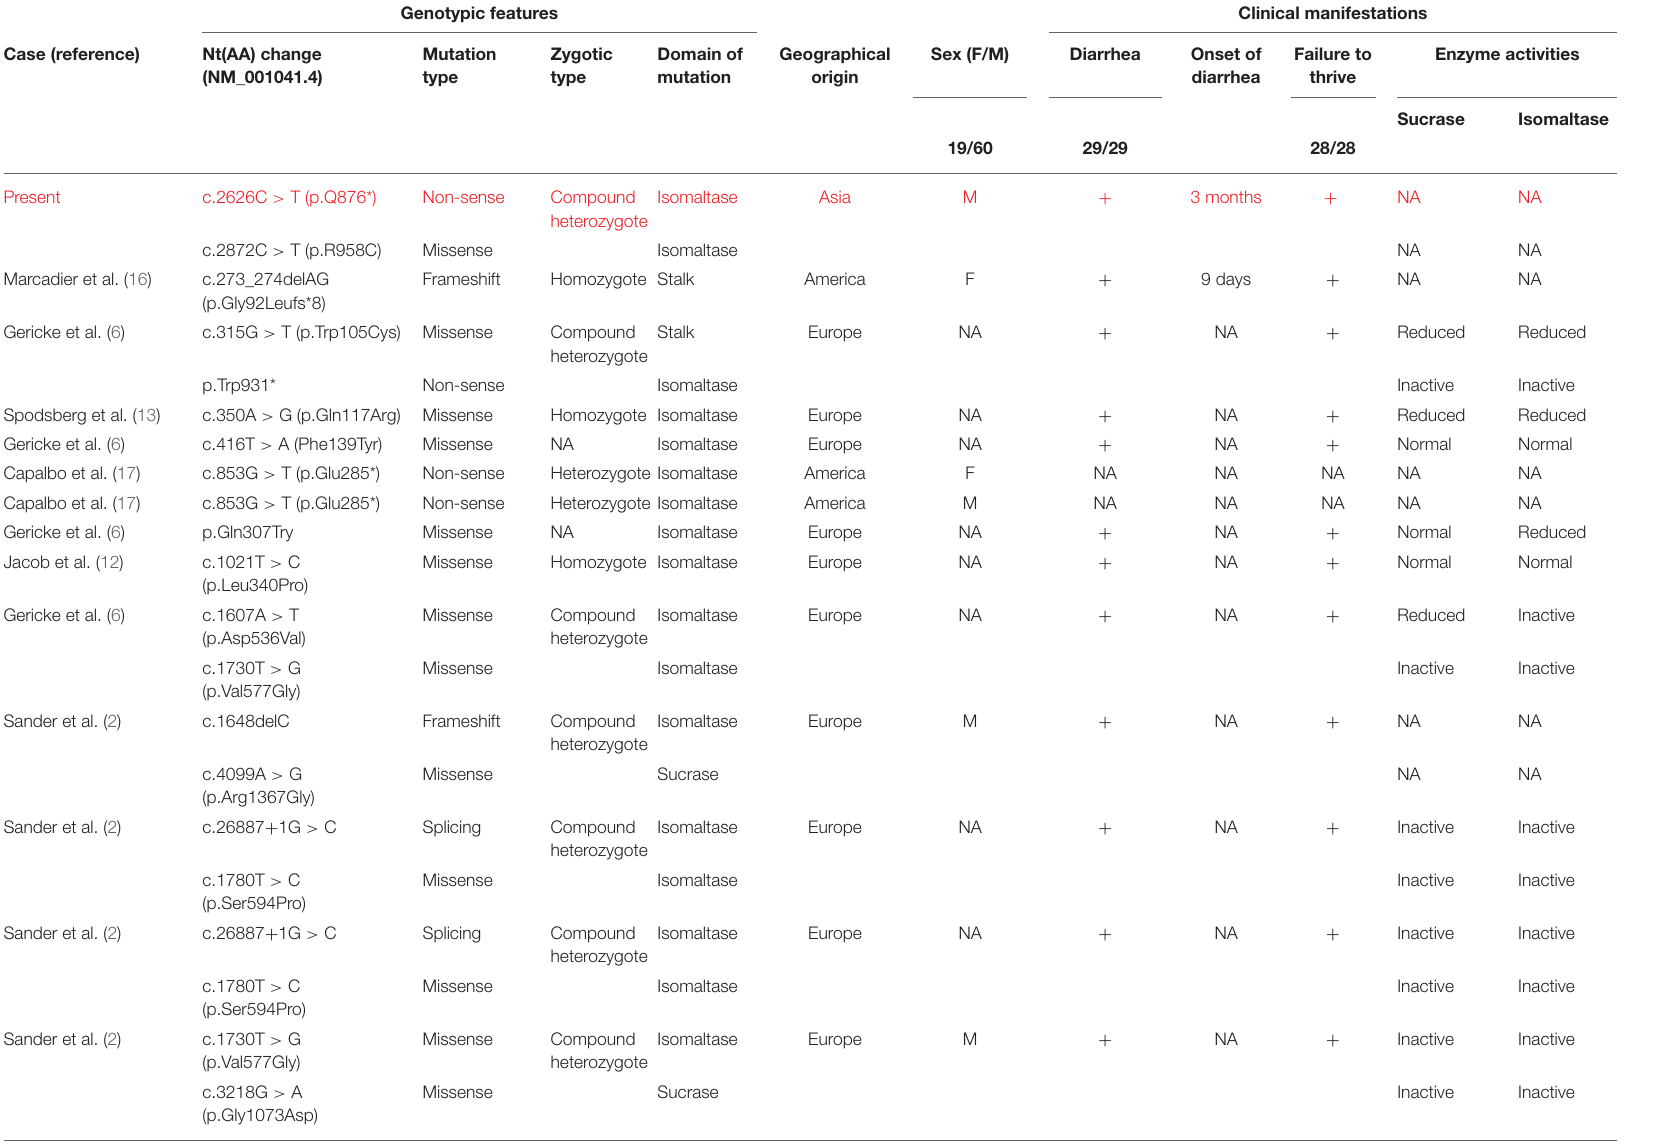
TABLE 1 | Genotypic and phenotypic features of all reported patients with CSID and SI